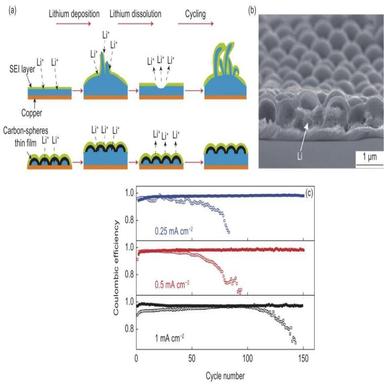
a) Schematic diagrams of the Li deposition/dissolution processes on different substrates. (b) SEM image after initial Li deposition. (c) Cycling performances at different current rates. Reproduced by permission of Nature Publishing Group